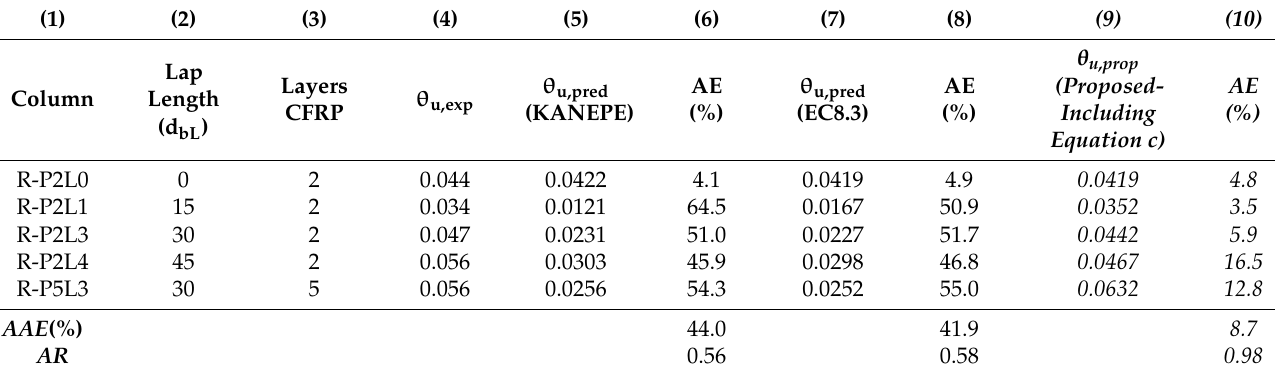
Table 6. Comparison of analytical and experimental values of chord rotation at